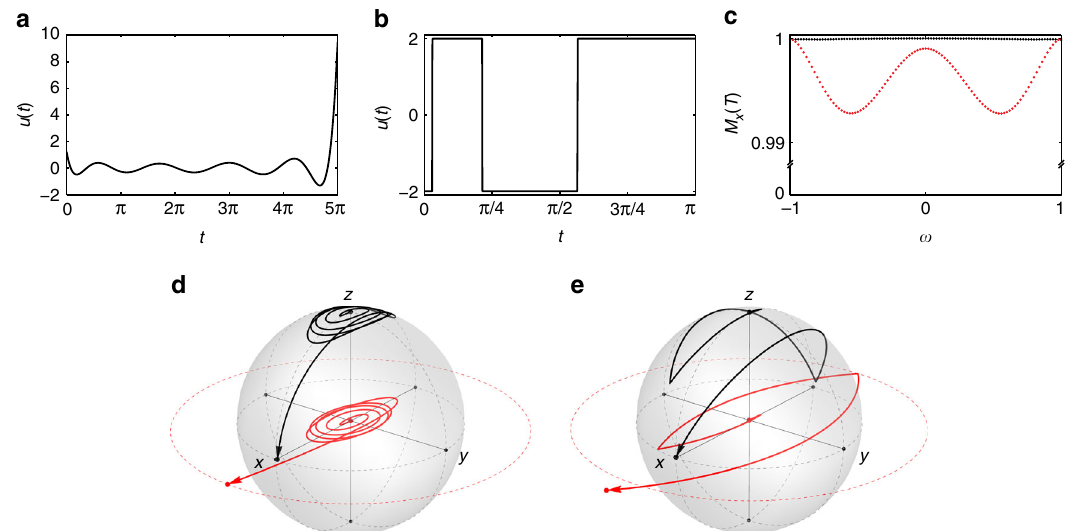
Fig. 2 Broadband excitation of spin ensembles. The a broadband minimum-energy and b amplitude-limited controls steering a family of harmonic oscillators with frequencies − 1 ≤ ω ≤ 1 from X 0 = (0,0) to X π /2 = ( π /2,0) with the corresponding trajectories, d and e , respectively, of the harmonic oscillator ( red ) and nuclear spin ( black ) for ω = − 1. These pulses achieve c high- fi delity magnetization excitation pro fi les, M x ( T ), over the frequencies − 1 ≤ ω ≤ 1, with average excitation of 1000 (minimum energy in black ) and 0.996 (amplitude limited in red ), respectively